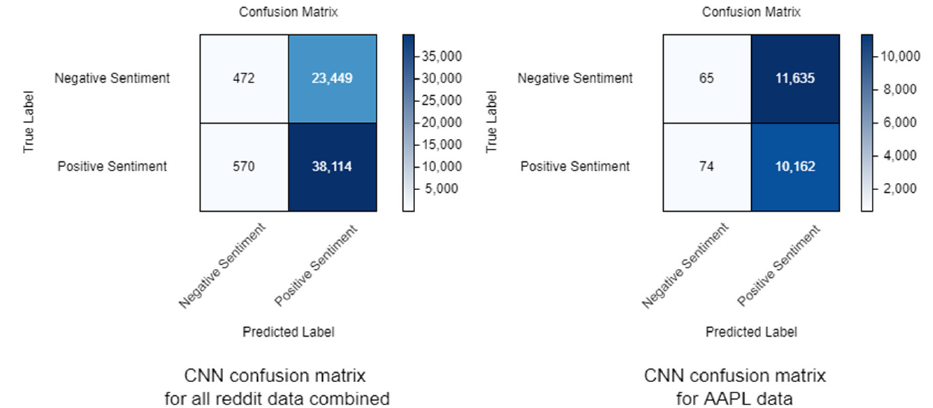
Figure 14. Two examples of CNN confusion matrices.